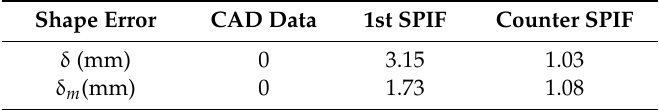
Figure 12. Experimental results and 3D scanned results of the circular cup shape after ( a ) the 1st. and ( b ) the counter SPIF, and ( c ) section view. Table 4. Initial experimental conditions of the 1st and the counter SPIF.